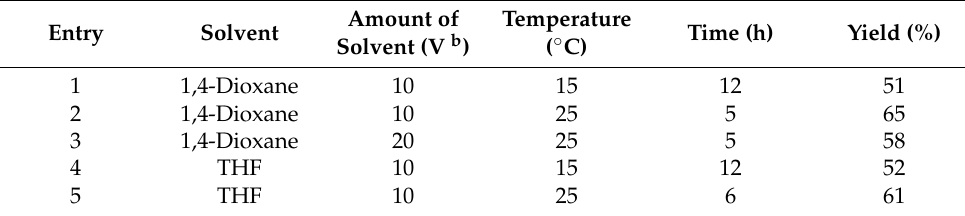
Table 2. Optimization of amine–carboxylic acid coupling reaction in Step 3 a of Route